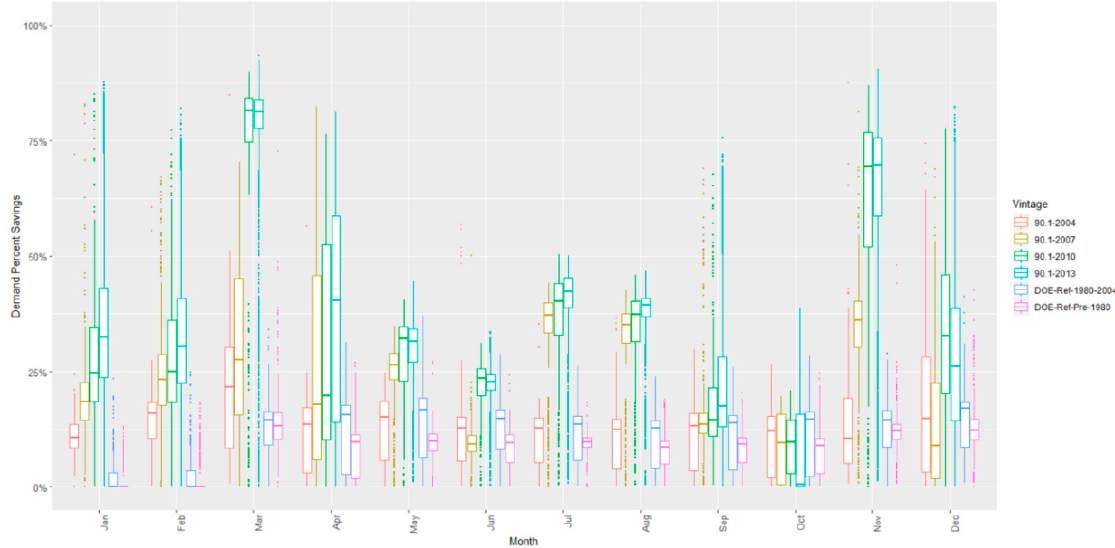
Figure 5. Potential demand reduction achievable with 2.2 °C pre-conditioning by building vintage.